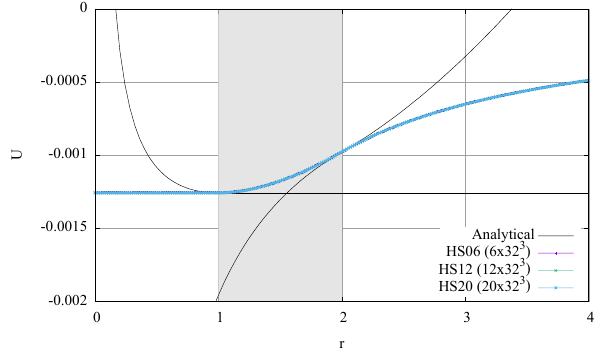
Figure 9. Gravity potential U as a function of the radial coordinate r . The gray area symbolises the spherical